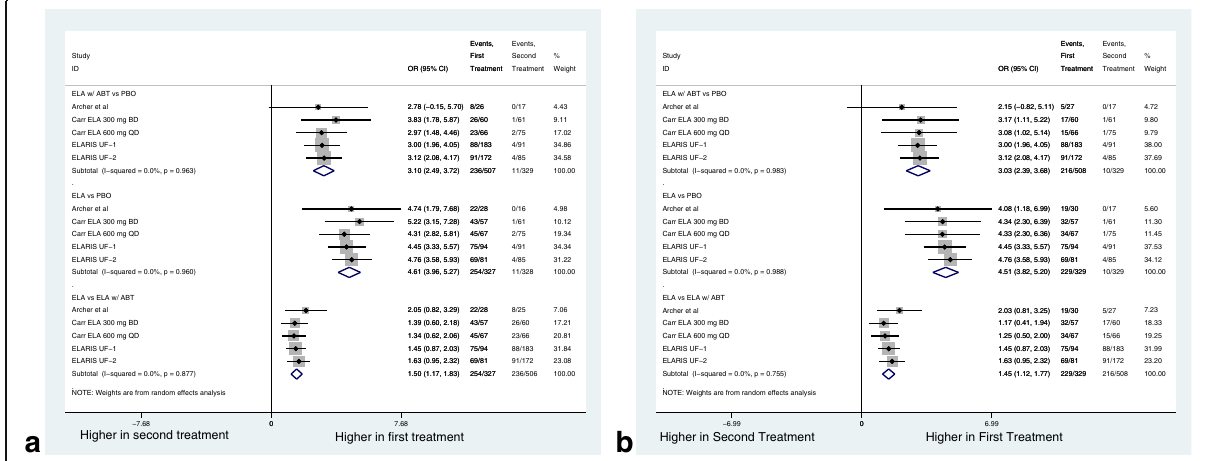
Fig. 3 Forest plots comparing: a suppression of bleeding and b amenorrhea, across treatments